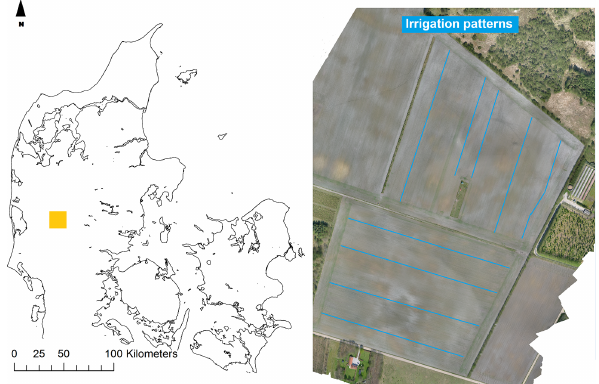
Figure 1. The two barley fields located in western Denmark (or- ange square: 56.037644 ◦ N, 9.159383 ◦ E). Right-hand side shows an orthophoto of the two barley fields. Blue lines show tramlines in which irrigation guns were